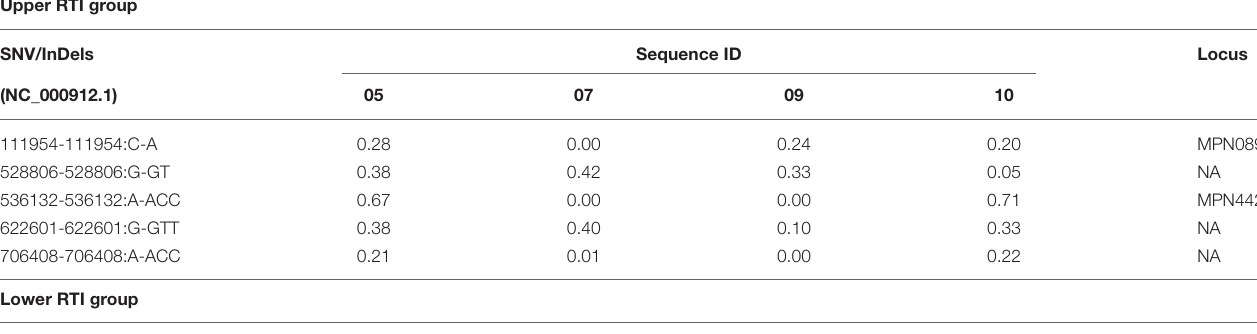
TABLE 2 | SNV/InDels frequencies of the isolates from symptomatic groups. Upper RTI group